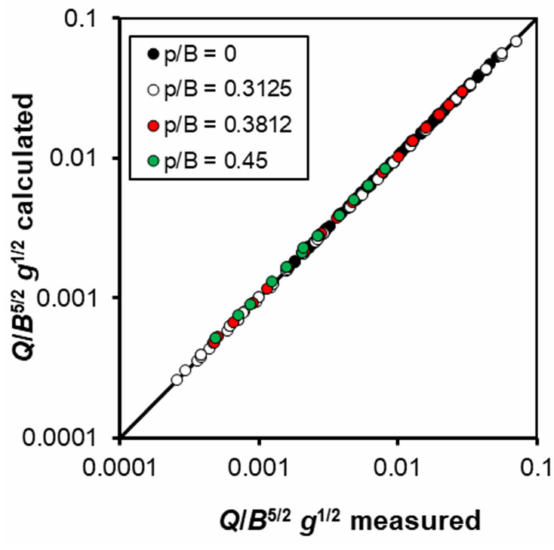
Figure 3. Comparison between the measured Q for calibrating dataset.